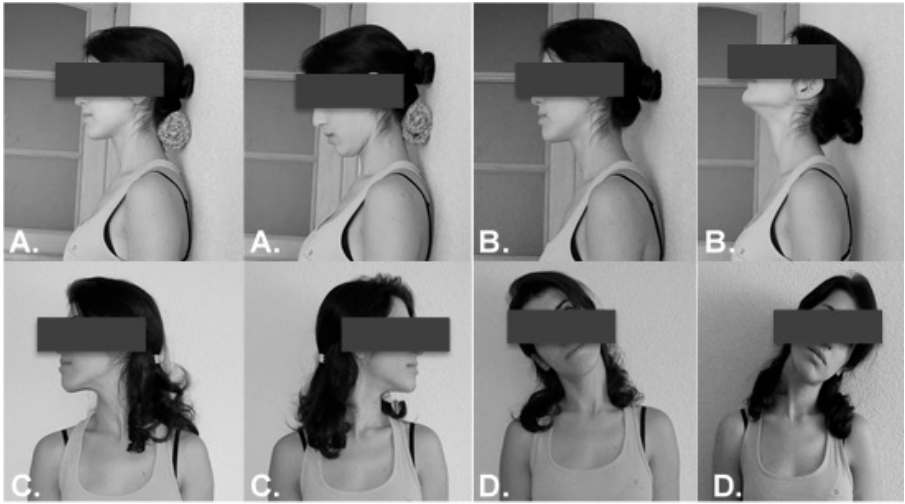
Figure 3. Neck exercises. ( A ) Flexion; ( B ) extension; ( C ) rotation; ( D ) lateral flexion.